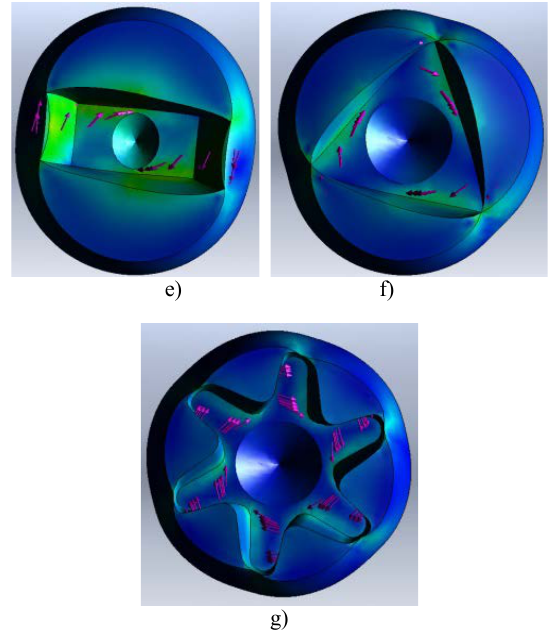
Fig. 3. The result of simulation us ing di fferent standard profiles; a) hexagon; b) pentagon; c) square; d) cruciform slot; e) flat slot; f) triangle; g) Torx